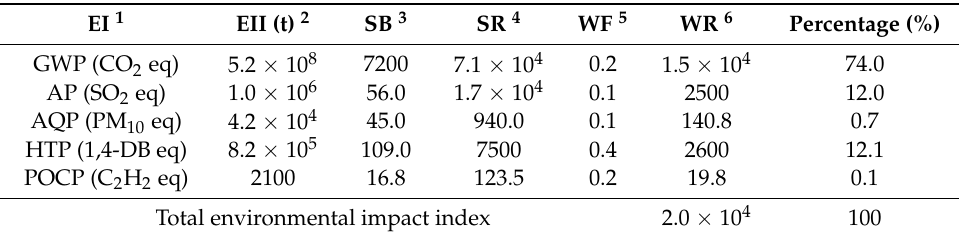
Table 7. Environmental impacts of switchgrass-based